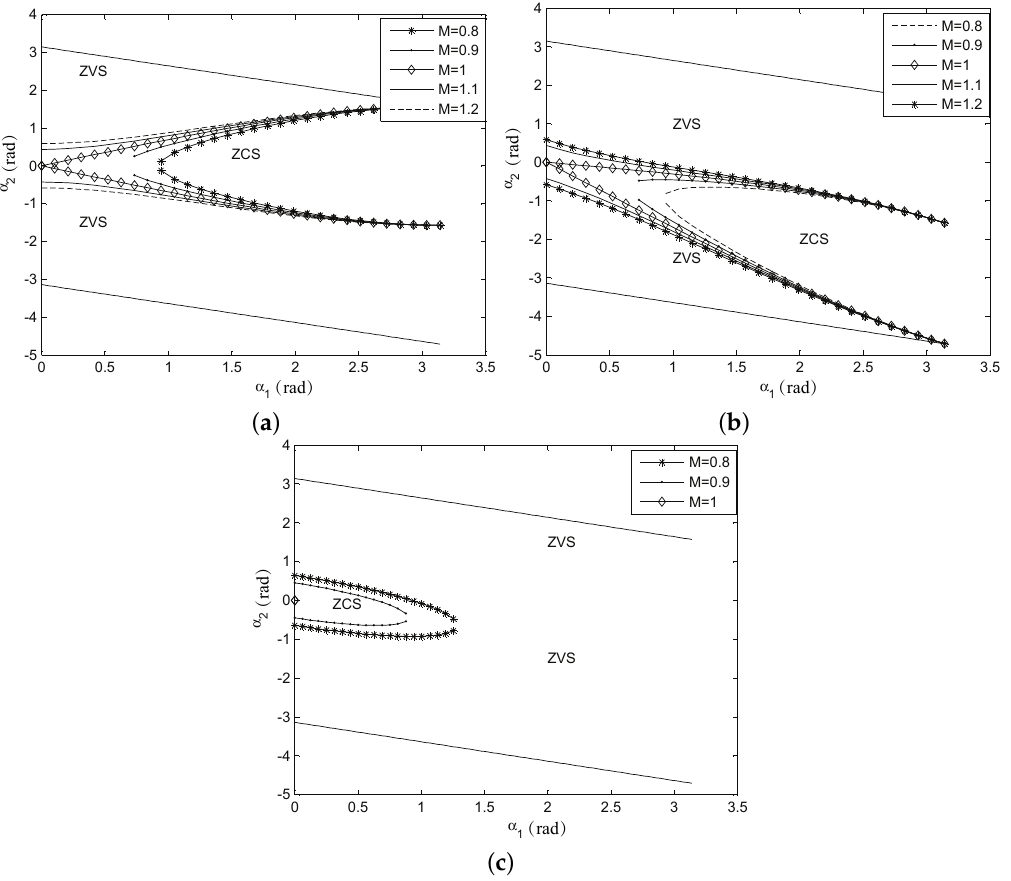
Figure 5. Soft-switching conditions of switches ( a ) S 1 , S 2 , ( b ) S 3 , S 4 , and ( c ) Q 1 , Q 2 , Q 3 , Q 4 with regards to the two phase-shifts and the voltage gain M . ZVS, zero-voltage